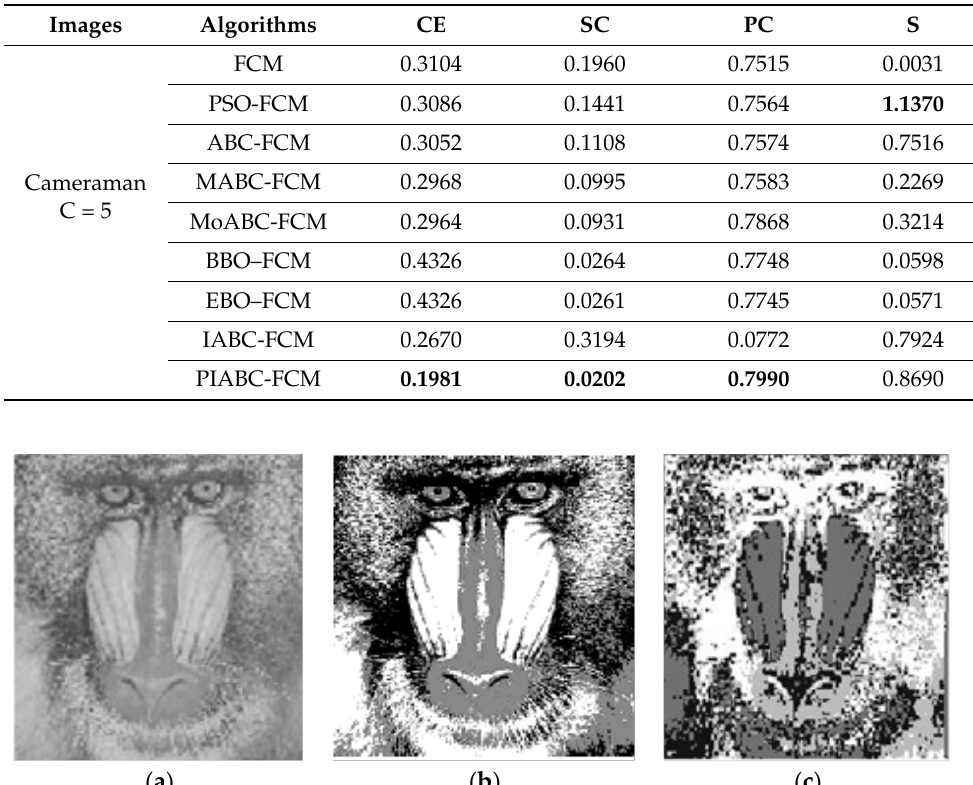
Table 4. Outcomes of PIABC-FCM and other clustering algorithms on the Cameraman image.